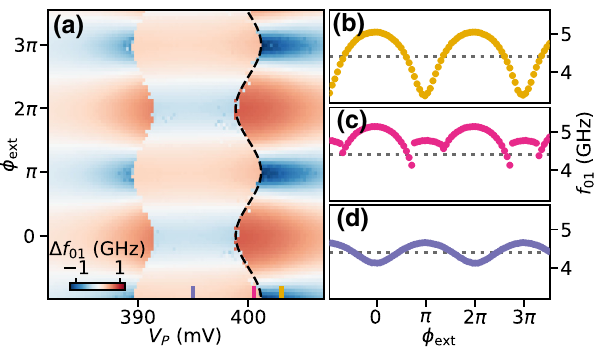
FIG. 4. The flux and plunger-gate dependence. (a) The trans- mon frequency shift with respect to the frequency set by the ref- , versus V P and φ ext as extracted erence junction, (cid:9) f 01 = f 01 − f 0 01 from two-tone spectroscopy. The dashed line is a sinusoidal guide for the eye, denoting the transition boundary in line with the theoretical expectation [60]. (b)–(d) Three line cuts of f 01 versus φ ext at representative V P values, indicated in (a) and . Throughout the Figs. 3(b)–3(e). The dotted line indicates f 0 01 figure, V T = 182